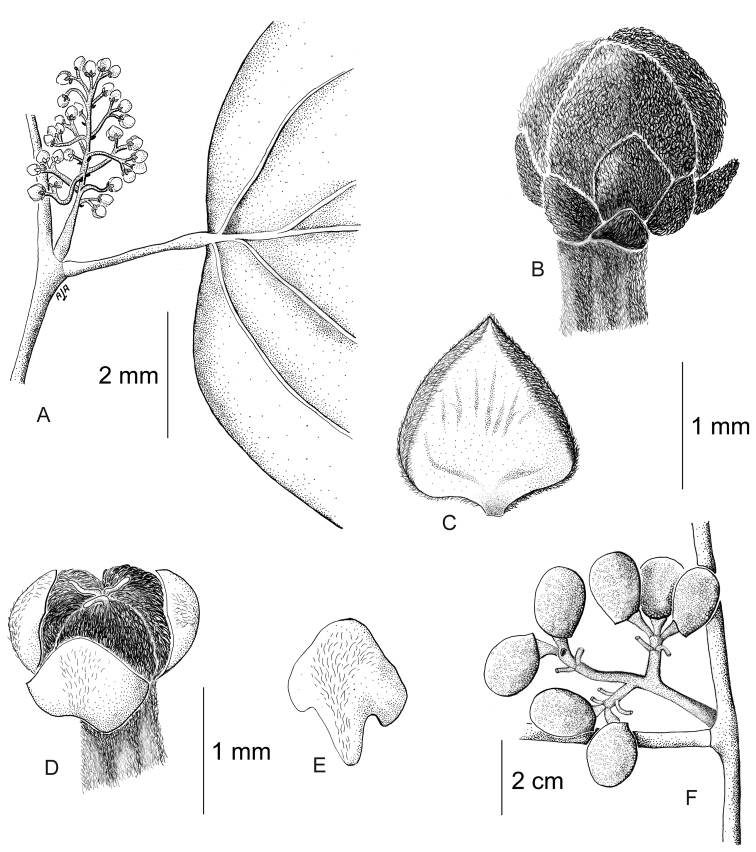

Curarea
toxicofera pistillate plant: A flowering branch B flower bud C innermost sepal, adaxial surface D petals and carpels E petal abaxial surface F infructescence (A–E based on Gentry et al. 21624
F based on Revilla et al. 2566).